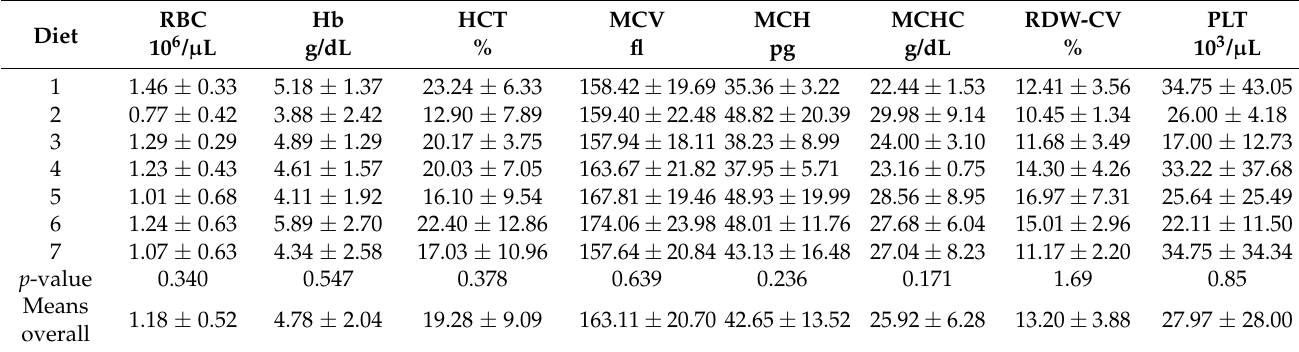
width (RDW-CV), and platelet (PLT). values between the control and BSFLM fed fish (Table 6). Table 6. Blood parameters after 12 weeks of feeding with control (0% BSFLM and 100% FM), and FM replaced at 10%, 20%, 40%, 60%, 80%, and 100% of the BSF.